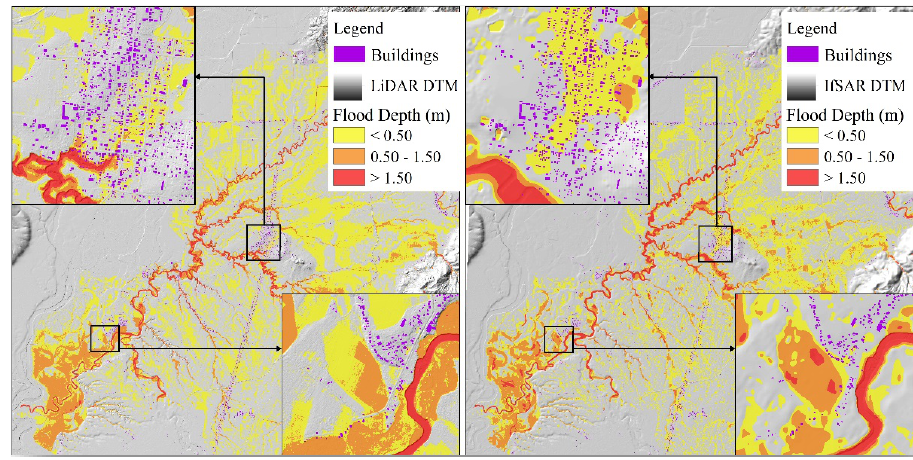
Fig. 5: Simulated flood using LiDAR and IfSAR DEMs Table 3: Accuracy tests of flood simulation models using LiDAR and IfSAR DEMs